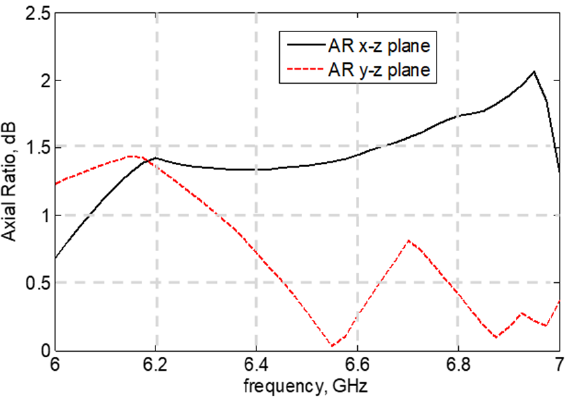
Figure 19. Simulated axial ratio of the tag antenna against frequency in x–y plane and y–z plane.